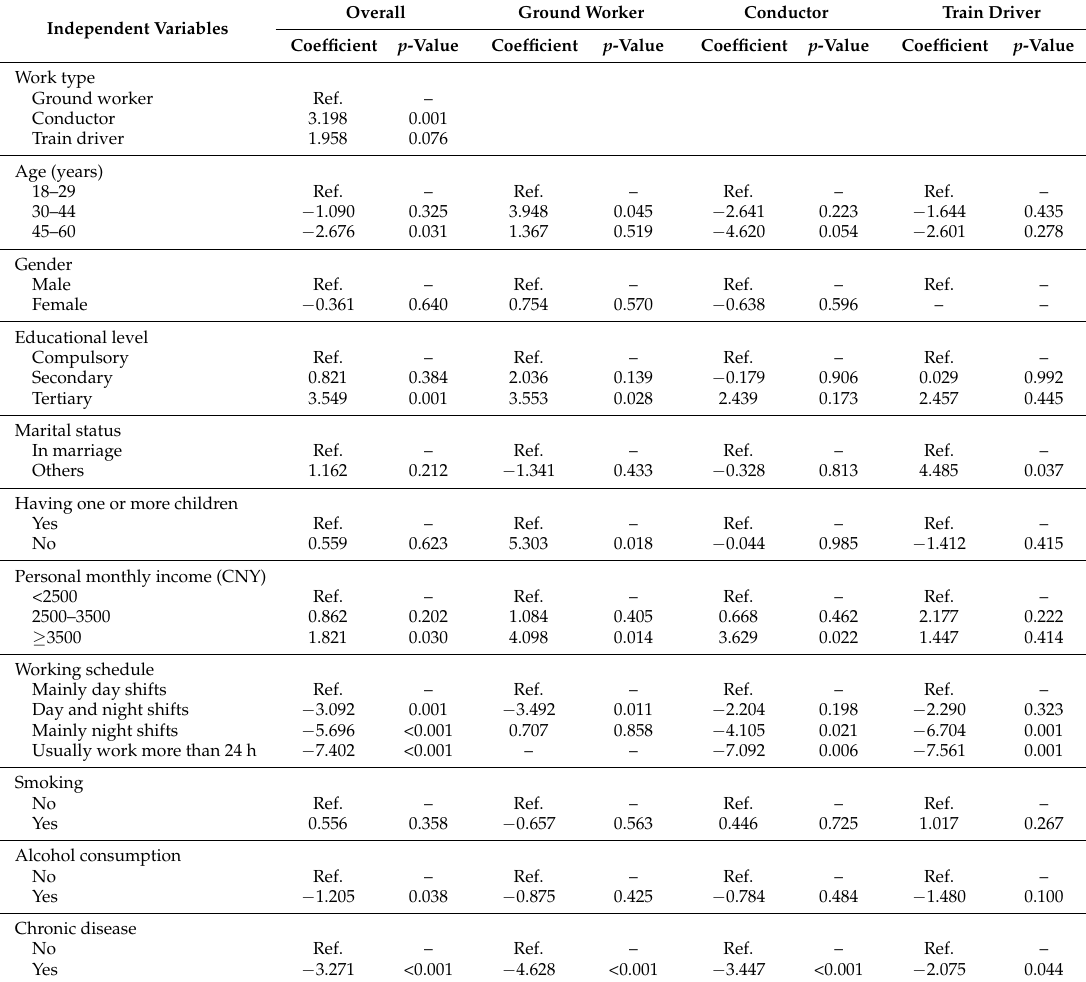
Table 2. Multivariable linear regression on physical component summary scores of SF-36v2 # . Overall Ground Worker Conductor Train Independent Variables